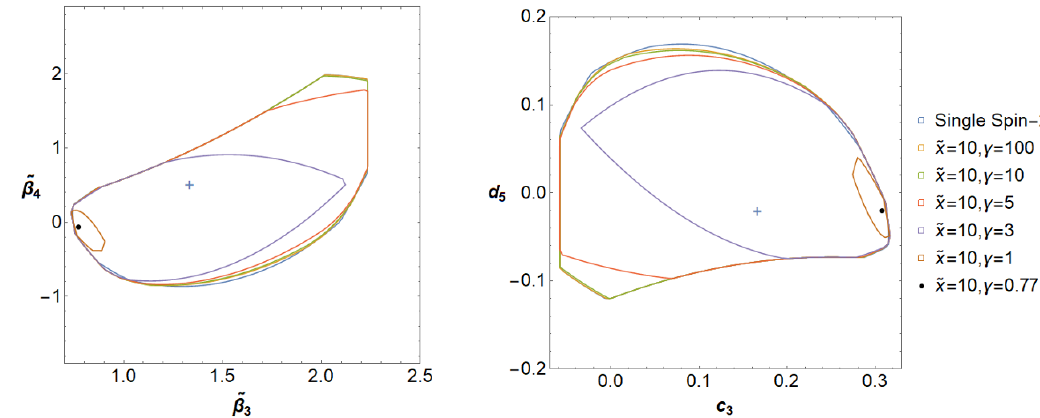
Figure 14 . The allowed parameter regions in the case of ~ x ! 1 for di(cid:11)erent values of (cid:13) . In particular, we set ~ x = 10 and ~ (cid:11) 3 = ~ (cid:11) 4 = 0. For large (cid:13) (as in the limit (6.8)) the allowed